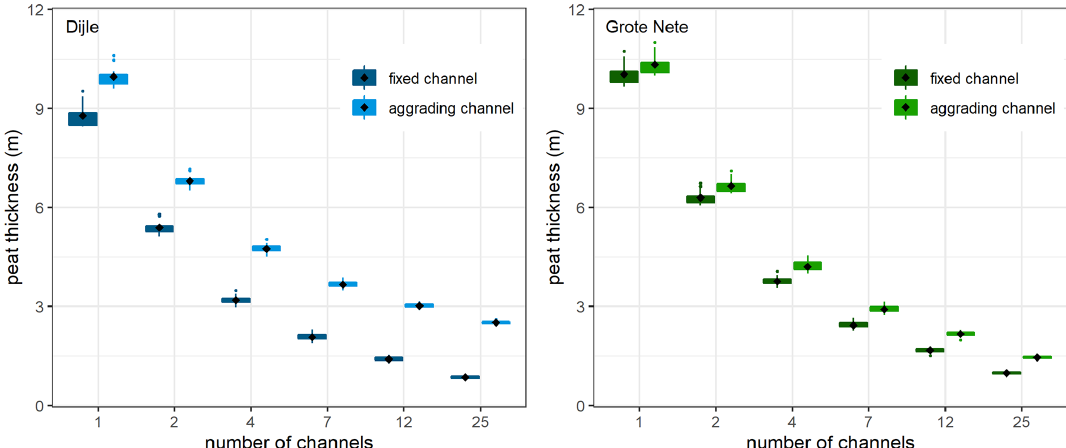
Figure 12. Boxplots of the simulated peat thickness (m) over all scenario combinations after 10000 years of simulation for the Dijle and Grote Nete rivers for different numbers of channels. The simulations assume channels with a fixed position in the substrate ( fixed channel ) or channels which aggrade vertically at a fixed rate ( aggrading channel ). The mean value is indicated by a black diamond. The box indicates all values within the 25th to 75th percentile range, and the whiskers represent all values within the range from the 25th percentile to 1.5 times the interquartile range to the 75th percentile plus 1.5 times the interquartile range. Coloured dots represent all other values outside this